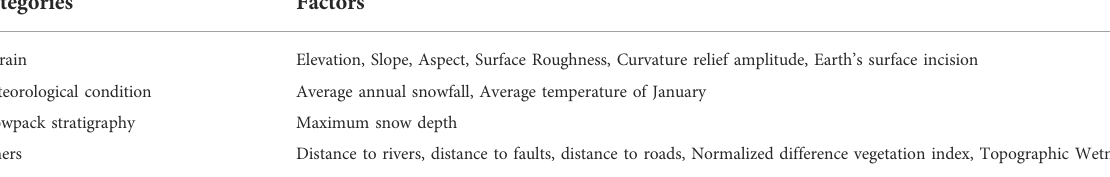
TABLE 1 Selected conditioning factors of a snow